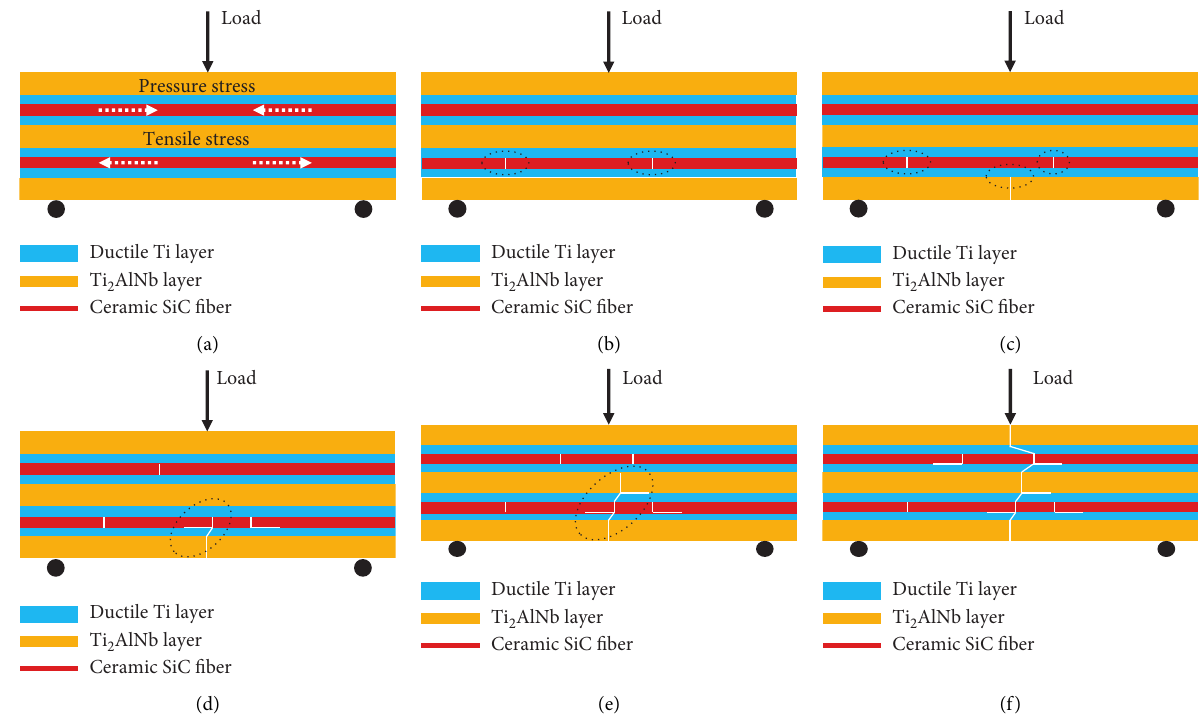
Figure 11: Failure mechanism schematic diagrams for the three-point bending of the composite: (a) initial loading stage; (b) stage of brittle fiber fracture under the load; (c) stage for the formation of crack sources on the surface; (d) initial stage of crack propagation; (e) cross-layer stage of crack propagation; and (f) failure stage of crack